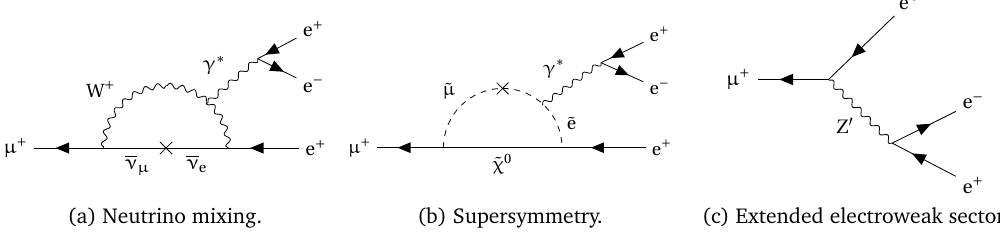
Figure 1: The decay µ → eee via neutrino mixing and in other extensions of the Standard